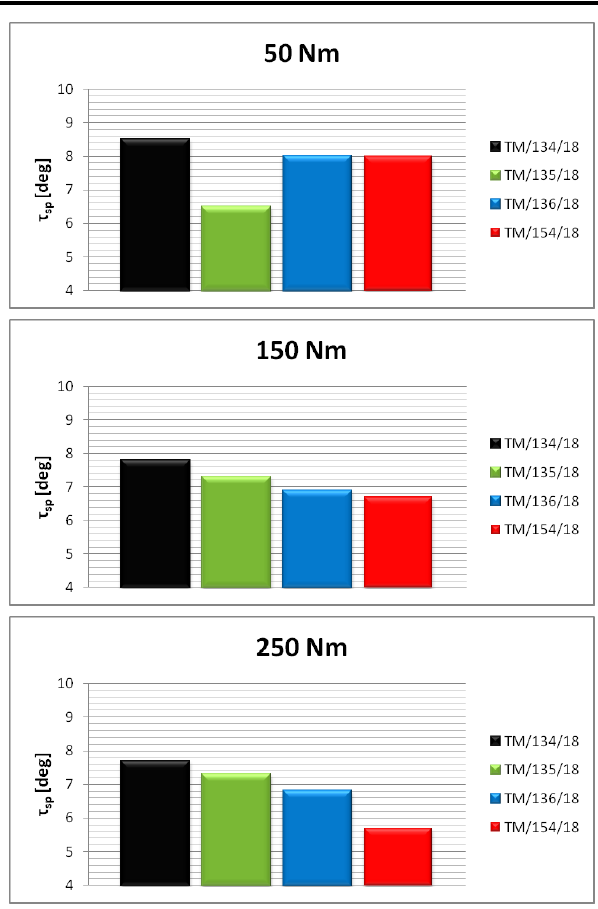
Fig. 3. Fuel self-ignition delay (t sp ) and NO x in the exhaust gas at selected duty points of the engine for the four tested fuels